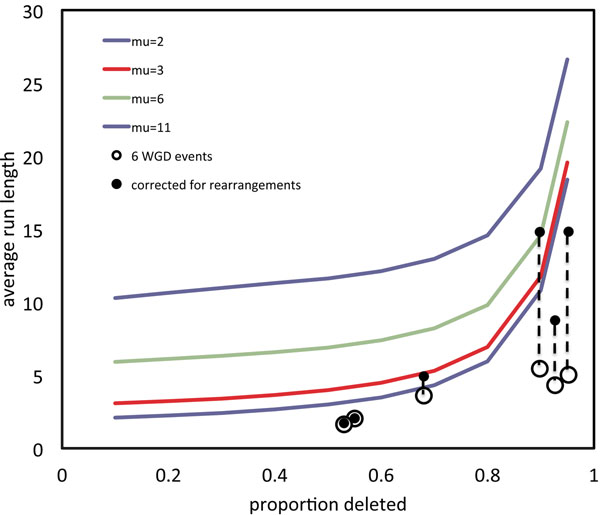
Single copy runs in WGD descendants compared to model Mean deletion run length in WGD descendants, uncorrected and corrected for rearrangements, compared to average length of run of single copy genes in the two-sided model for µ = 2, 3, 6 and 11.